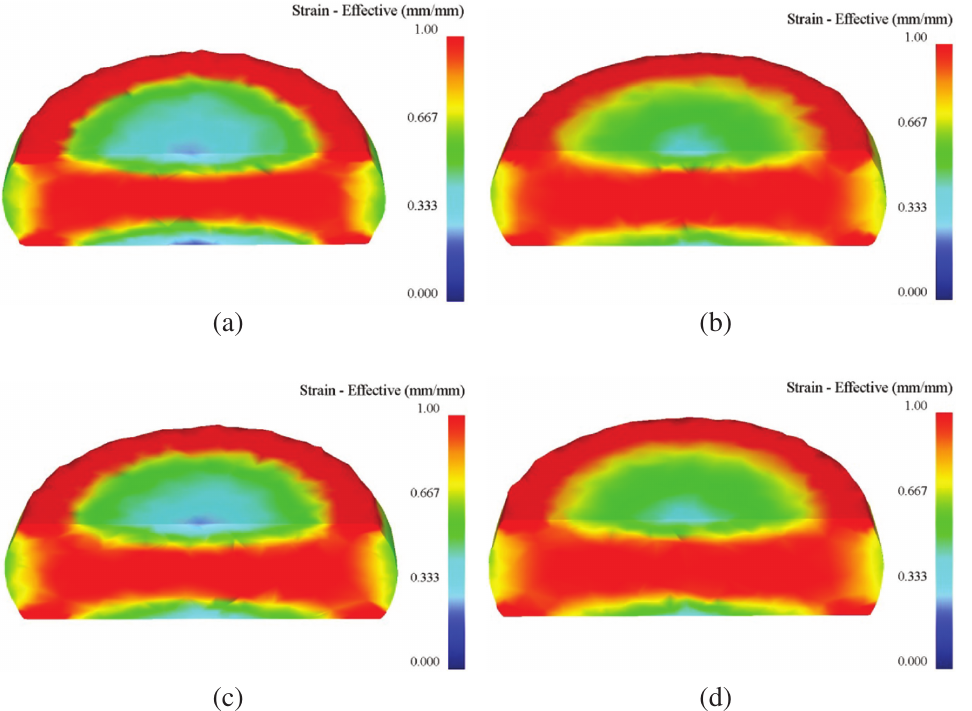
Figure 11: The effective strain distributions under the temperature of 1203K and strain rate of (a) 0.01s − 1 , (b) 0.1s − 1 , (c) 1s − 1 and (d) 10s − 1 .